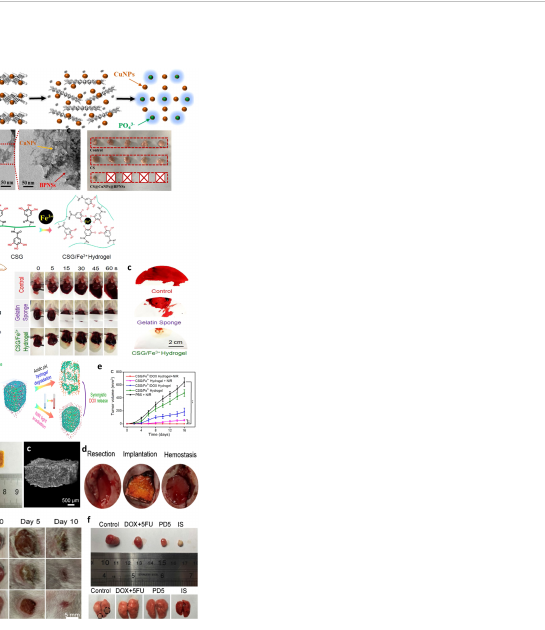
FIGURE 12 Post-surgery chitosan injectable gels/implanted scaffolds for treating recurrent cancer and MRD. (A) Magnetic hydrogel for the treatment of breast cancer metastasis. (a) Schematics of design (top) and transformation mechanism (bottom) of GC-ferro fl uids to form a magnetic hydrogel. (b) TEM and (c) SEM images of porous magnetic hydrogels. Reprinted from (141) with permission, Copyright (2019) WILEY ‐ VCH Verlag GmbH & Co. KGaA, Weinheim. (B) Injectable biodegradable hydrogel for multiple tumor and recurrent cancer therapy. (a) Schematic for the degradable process of the CS@CuNPs@BPNSs hydrogel. (b) TEM image (c) and ef fi cacy of CuNPs@BPNSs for complete tumor remission in the lung cancer recurrence model. Reprinted from (142) with permission, Copyright (2021) Elsevier. (C) Thermosensitive injectable halloysite-chitosan hydrogels as drug carriers for inhibition of breast cancer recurrence and tissue reconstruction. (a) Synthesis procedure for thiolated halloysite nanotubes (HNT) for DOX loading and hydrogel formation by cross-linking with chitosan through SS bonds and electrostatic interactions. Reprinted from (20) with permission, Copyright (2021) Elsevier. (D) Anti-in fl ammatory and antibacterial catecholic chitosan hydrogel for rapid surgical trauma healing and subsequent prevention of breast tumor recurrence. (a) Synthesis route of CSG/Fe +3 /DOX hydrogel by Fe +3 chelation of chitosan (CS) – gallic acid (GA) and DOX loading. (b) hemostatic potential in a model of rat liver bleeding, (c) typical bloody fi lter papers. (d) pH/NIR- responsive DOX (e) Effective 4T1 tumor recurrence of the CSG/Fe3+/DOX hydrogel. Reprinted from (63) with permission. Copyright (2020) Elsevier. (E) 3D printed intelligent scaffold (IS) stops bleeding and adsorbs CTC after surgery to prevent recurrence and distal metastasis of breast cancer. (a) Electro-hydrodynamic jet 3D printing process of drug-loaded chitosan – gelatin (CG) scaffold, (b) macroscopic, (c) microscopic, (d) SEM images of implanted IS after 30 days, (e) potential of IS for wound healing and closure compared to gauze (control) and PLGA-DOX- 5FU (PD5) scaffold, (f) potential of IS for recurrent cancer and inhibiting breast cancer lung metastatic activity. From (144), Copyright (2020) Under Creative Commons Attribution License 4.0.